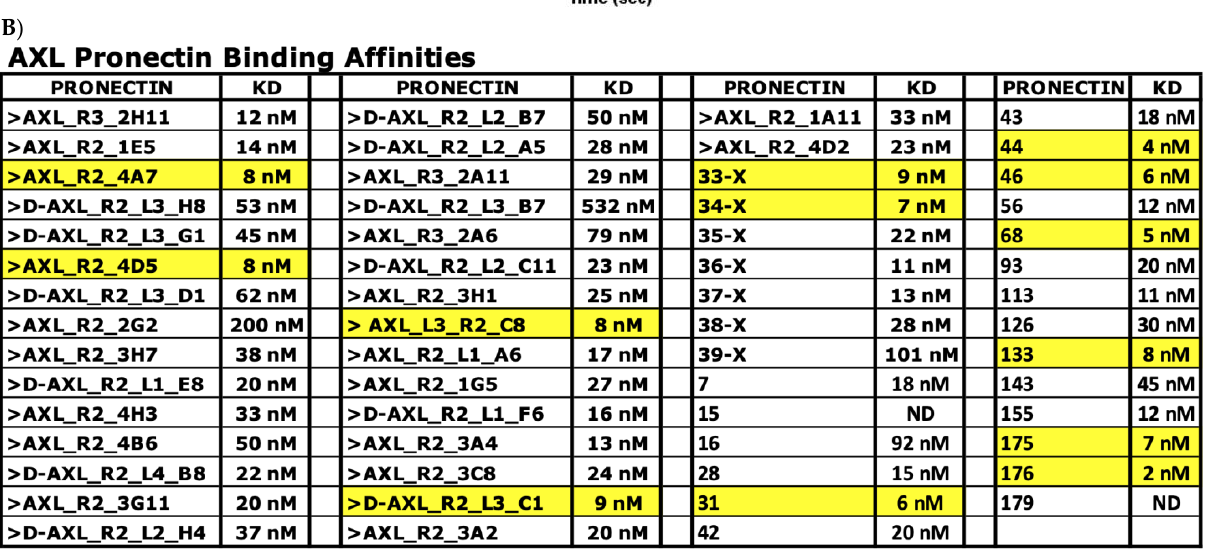
Figure 5. ( A ) Binding affinity curves for lead Axl binder Pronectin. ( B ) The binding affinities KD values for all 59 Axl Pronectins. The KDs < 10 nM are highlighted in yellow. The first 39 Pronectins were discovered by phage display and the additional 20 were new Pronectins discovered by yeast